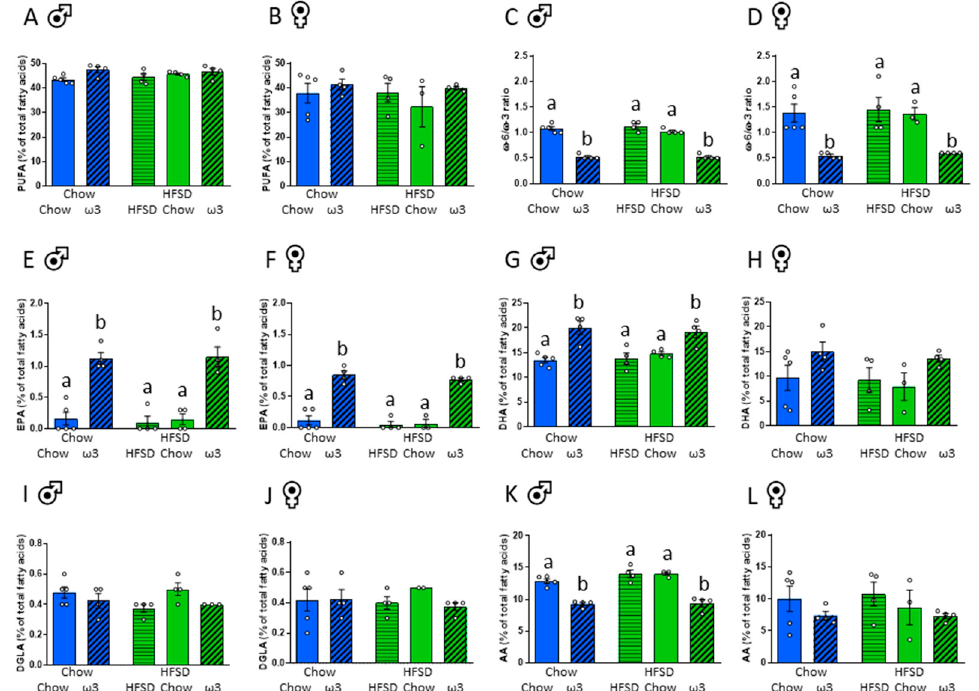
Figure 3. Effects of maternal pre- and post-conception diet on brain fatty acid composition. ( A ) Total polyunsaturated fatty acids (PUFAs), males. ( B ) Total PUFAs, females. ( C ) Ratio of ω 6 to ω 3 PUFAs, males. ( D ) Ratio of ω 6 to ω 3 PUFAs, females. ( E ) Eicosapentaenoic acid (EPA), males. ( F ) EPA, females. ( G ) Docosahexaenoic acid (DHA), males. ( H ) DHA, females. ( I ) Dihomogammalinolenic acid (DGLA), males. ( J ) DGLA, females. ( K ) Arachidonic acid (AA), males. ( L ) AA, females. HFSD: high-fat-high-sugar diet. Letters denote post hoc differences between groups ( p < 0.05). Data are mean ± SEM ( n = 3–5), presented as a percentage of total fatty acids. Each data point represents one pup per litter per sex.